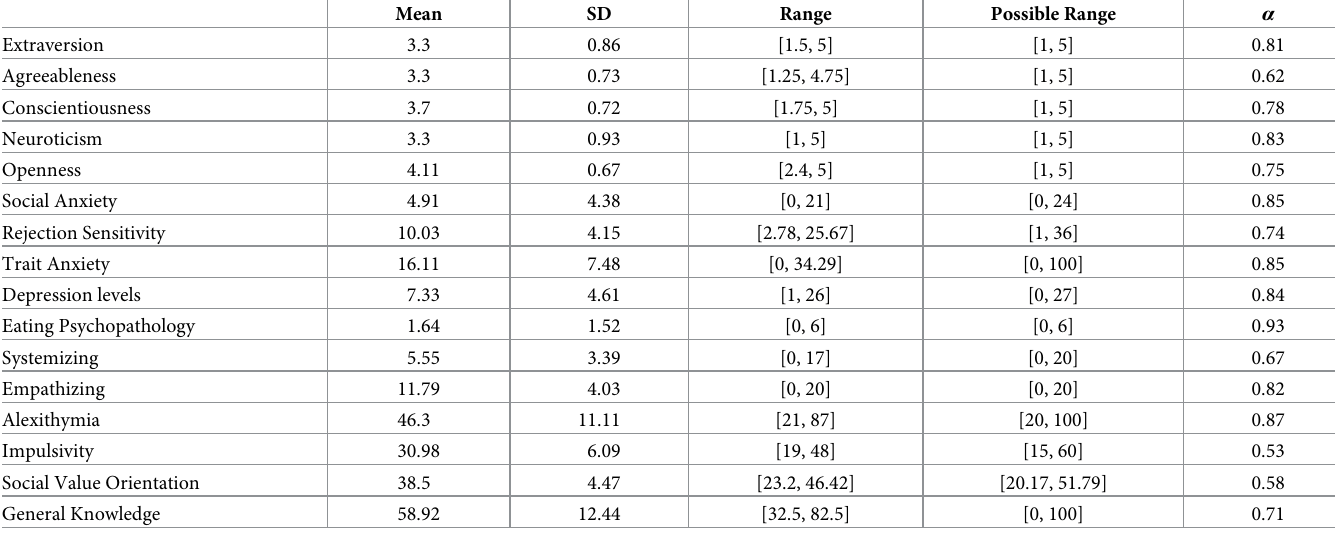
Table 1. Sample questionnaire